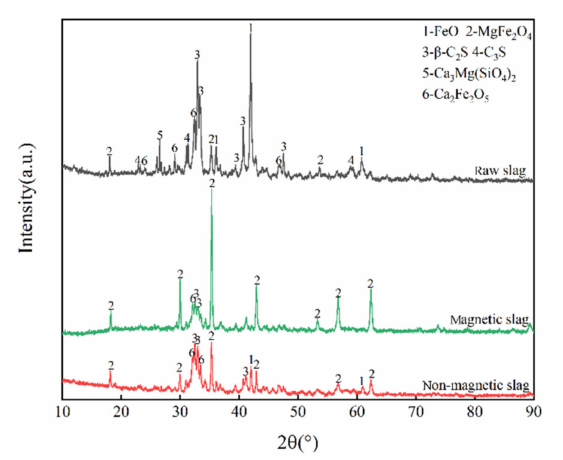
Figure 3. X-ray pattern of raw and magnetic separation